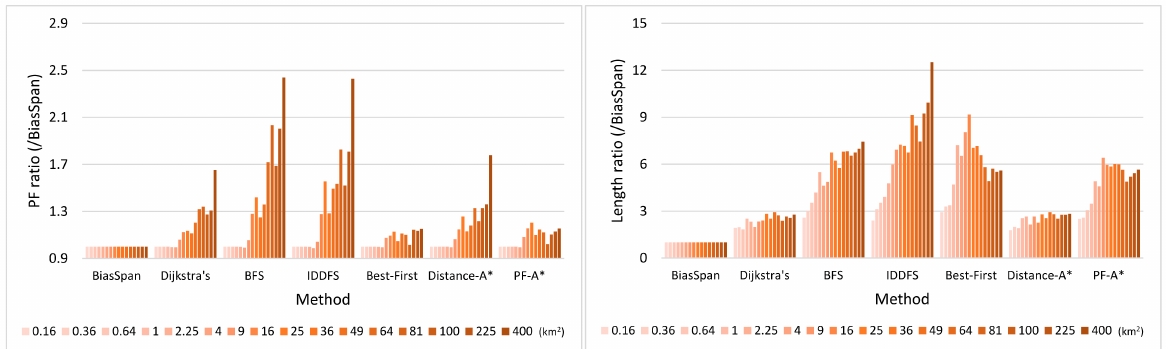
Figure 5. PF ratio ( left ) and length ratio ( right ) for methods under area range in Chicago